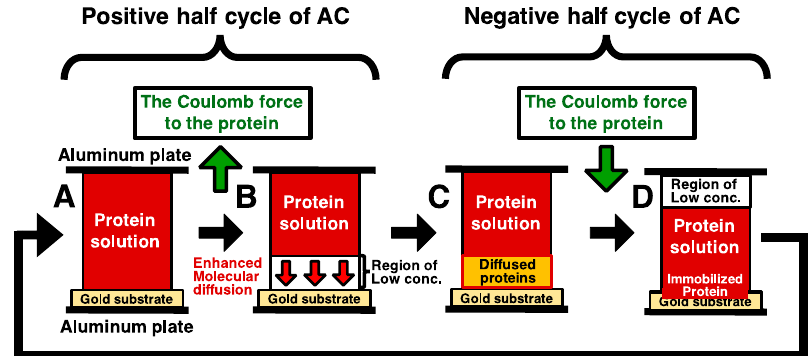
Figure 1. A model of immobilization method combining electrostatic transport and subsequent molecular diffusion of protein molecules ( A ). A pair of electrodes consist of a substrate electrode (the upper electrode) and the counter electrode (the lower electrode). The gap of the electrodes is filled with the protein solution, and low frequency AC electric field is applied. In this figure, green arrows show direction of Coulomb force ( B ). The proteins in solution are transported toward the upper electrode by Coulomb force with the application of positive half cycle of an AC electric field. The generated steep concentration gradient increases the transport rates of protein and thus enhances the molecular diffusion ( C , D ). When the electric field was sufficiently low during the gap between the positive and the negative half cycle, the proteins spread the low concentration area by enhanced molecular diffusion, followed by transportation of the proteins toward the substrate electrode by Coulomb force, and then the transported proteins are immobilized on a gold substrate surface. Repeating this cycle, the amount of immobilized proteins can be increased with the number of the repeated